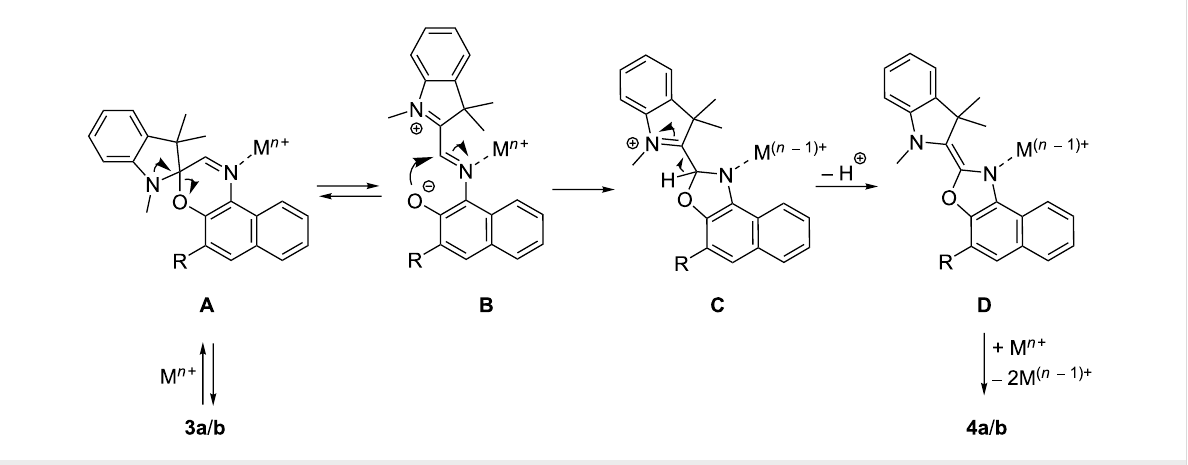
Scheme 4: Proposed mechanism for the formation of the oxazole derivatives 4a and 4b (cf. Scheme 3); M n + = Cu 2+ , Fe 3+ , Hg 2+